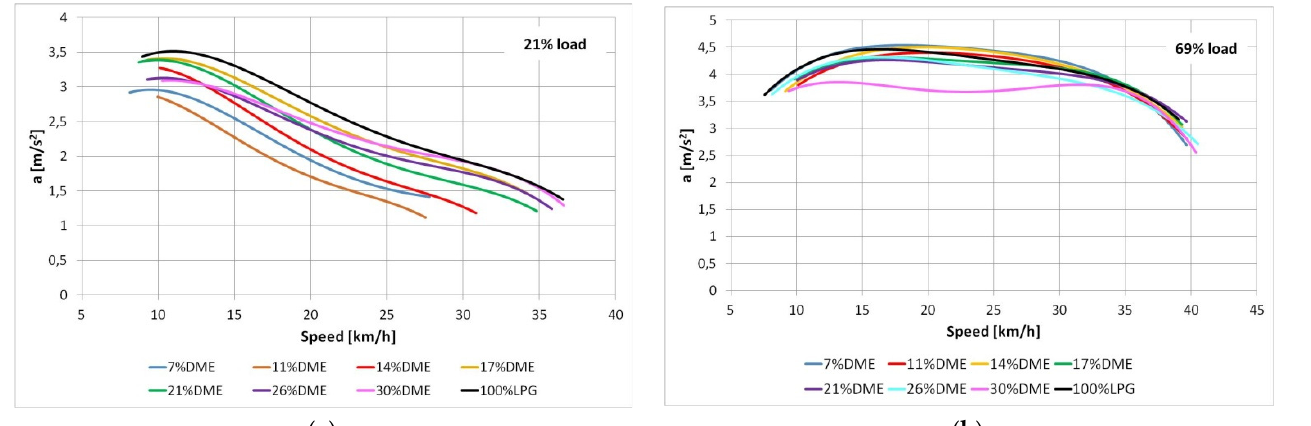
Figure 9. Maximum values of the dynamics factor for different mass fraction of DME and engine load.